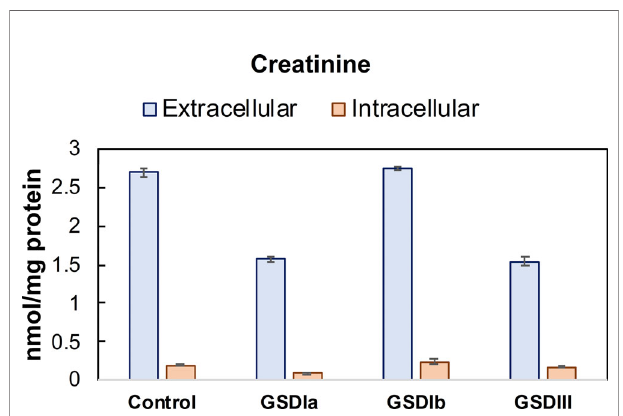
FIGURE 7 | Concentration of creatinine in conditioned medium and cells. Creatinine concentration was determined in cell lysates after 5 days in culture. Metabolite concentrations were determined by LC-MS/MS and normalized by total protein concentration. Control: n=2; GSDIa n =1; GSDIb n=1; GSDIII n=3, each by triplicate. Data are shown as mean ± standard error of the mean.